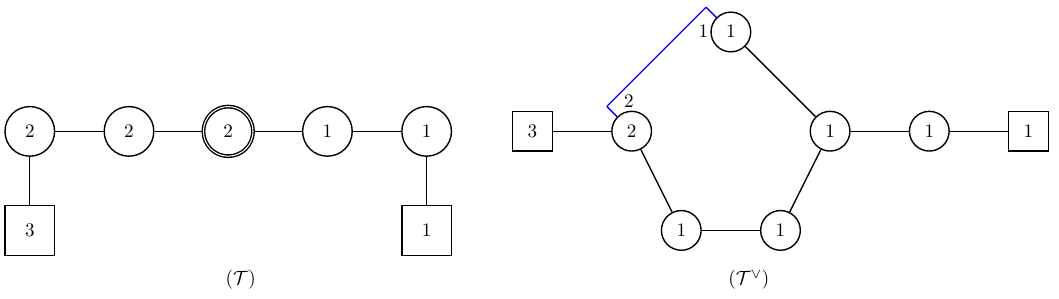
Figure 21 . The two Lagrangians for the 3d SCFT that arise from the circle reduction of the D 9 (SU(3)) .